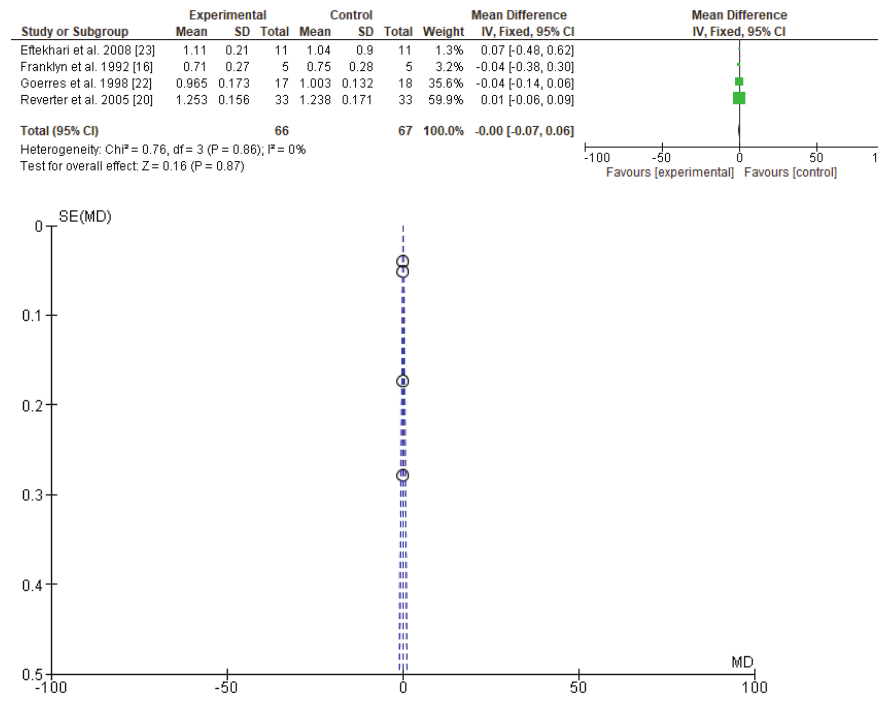
Figure 8 : TSH suppression and bone mineral density among men lumbar